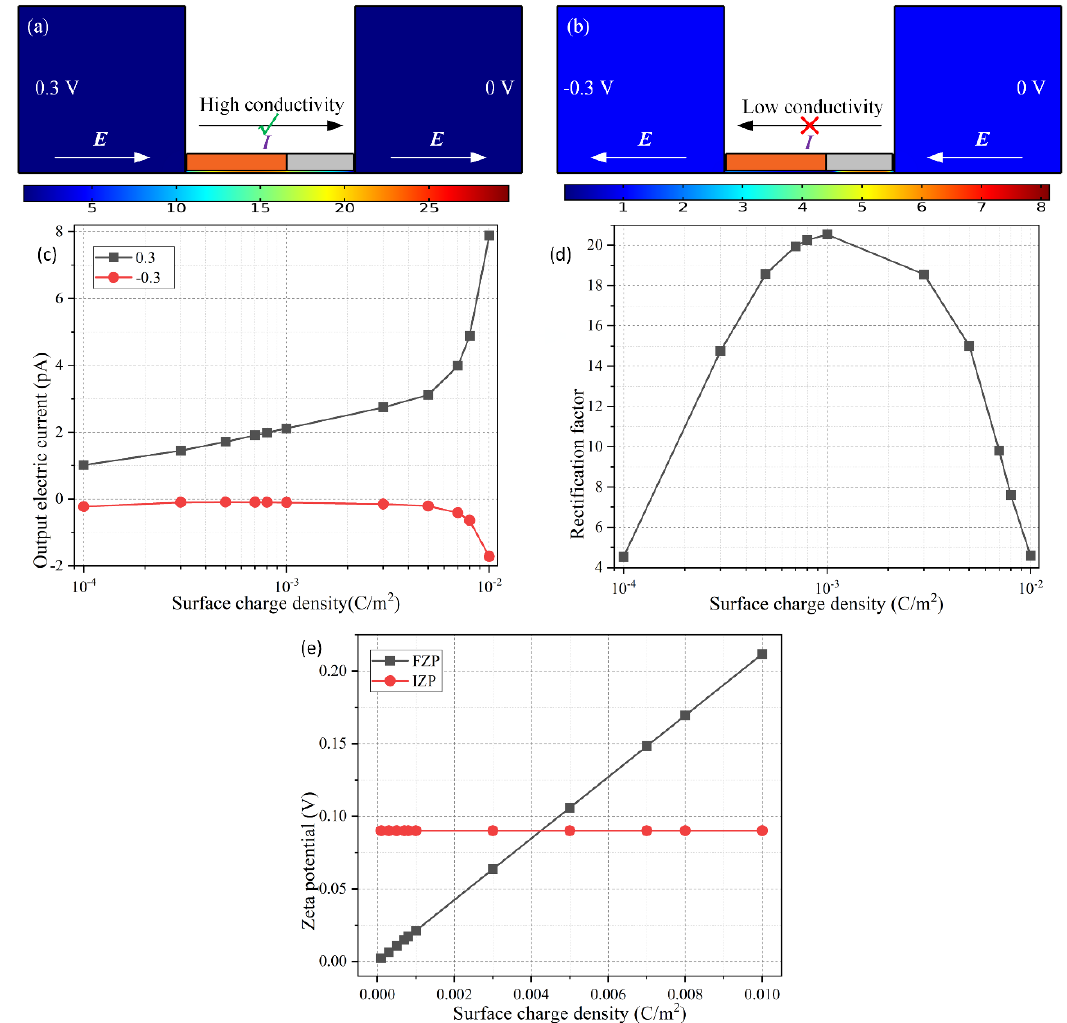
Figure 6. Effect of the native surface charge density of a positively-charged dielectric wall on the device rectification performance, under a given parametric space of R N =1 5 nm, L C = 600 nm, V S = ±0.3 V, and c 0 = 0.1 mM. ( a ) A surface plot of the nondimensional electrolyte concentration for the “on” working state, in which the forward electric current diminishes due to the IEZ formed at bipolar junction at the central portion of the metallic nanopore. ( b ) A surface plot of the nondimensional electrolyte concentration for the “off” working state, in which the backward electric current is well forbidden due to the IDZ formed at another bipolar junction between the metallic and dielectric walls. ( c ) The forward and backward output electric current, and ( d ) the rectification factor, and ( e ) analytical estimation of the zeta potential magnitude, as a function of the surface charge density.